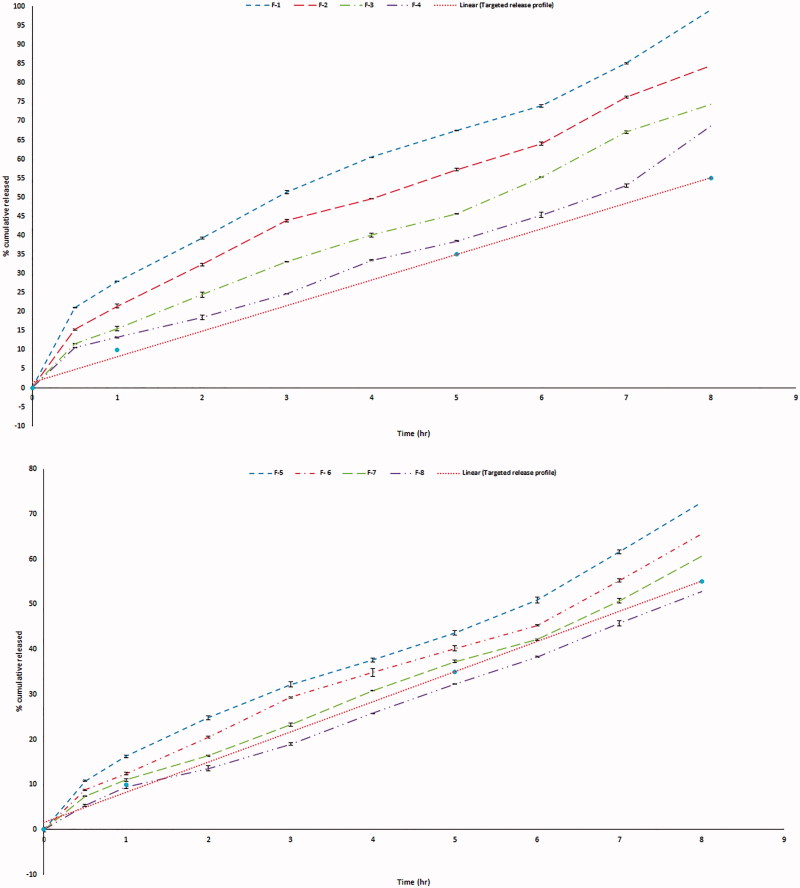
In vitro release profile of GBP in 0.1 N HCl (F-1 to F-8).